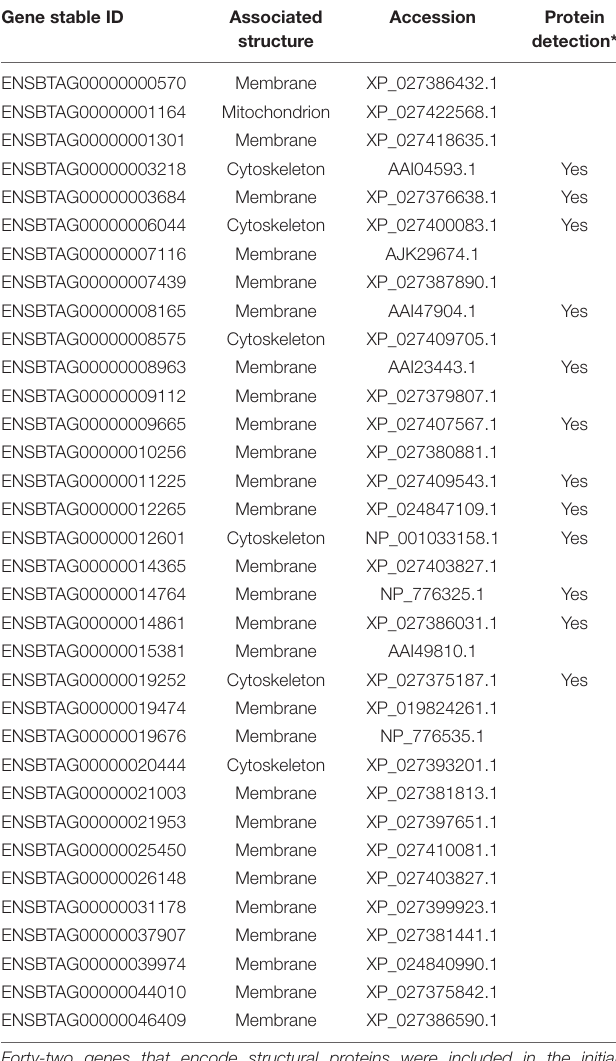
TABLE 3 | Structural protein genes identified as potential µ -calpain substrates. Gene stable